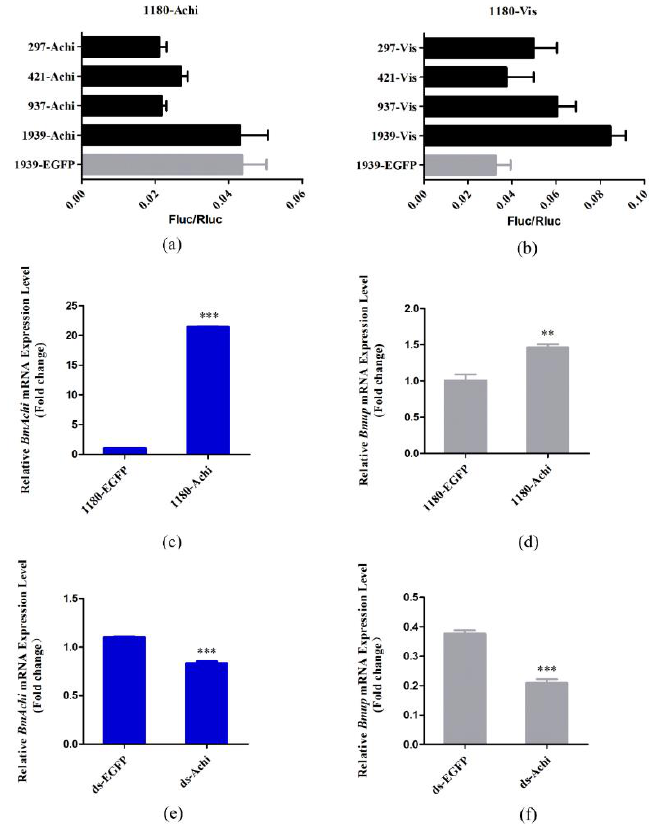
Figure 6. The regulatory effect of the transcription factor BmAchi on BmUP . ( a , b ) Dual luciferase reporter experiment on the transcription factor BmAchi/BmVis and BmUP promoters with different lengths. ( c , d ) Effect of Bmachi overexpression on BmUP expression in cells. Bmachi was over-expressed in BmN cells. Expression of BmUP was upregulated in the experimental group. A value of p < 0.05 was considered statistically significant (* p < 0.05, ** p < 0.01 and *** p < 0.001). ( e , f ) Effect of Bmachi instantaneous interference at the individual level on BmUP.